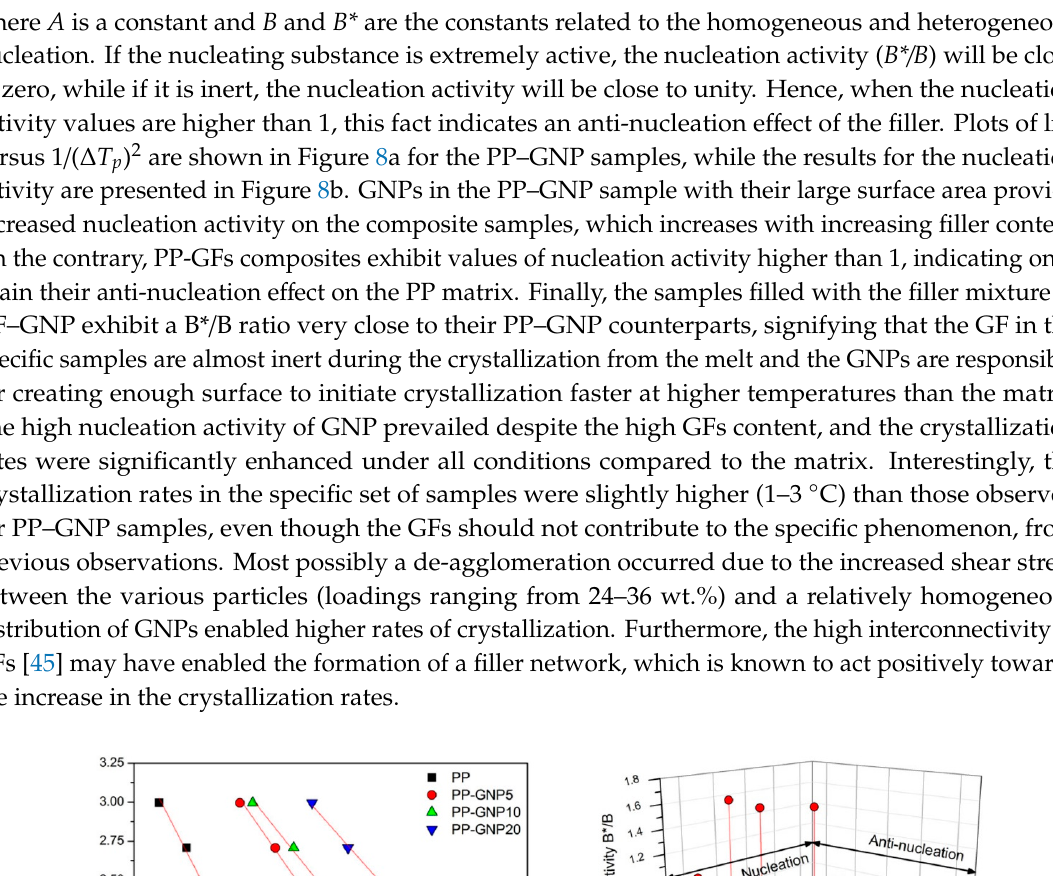
Figure 7. Differential scanning calorimeter (DSC) non-isothermal crystallization exothermic peaks recorded at different cooling rates for ( a ) PP and ( b ) PP–GNP10 composite.